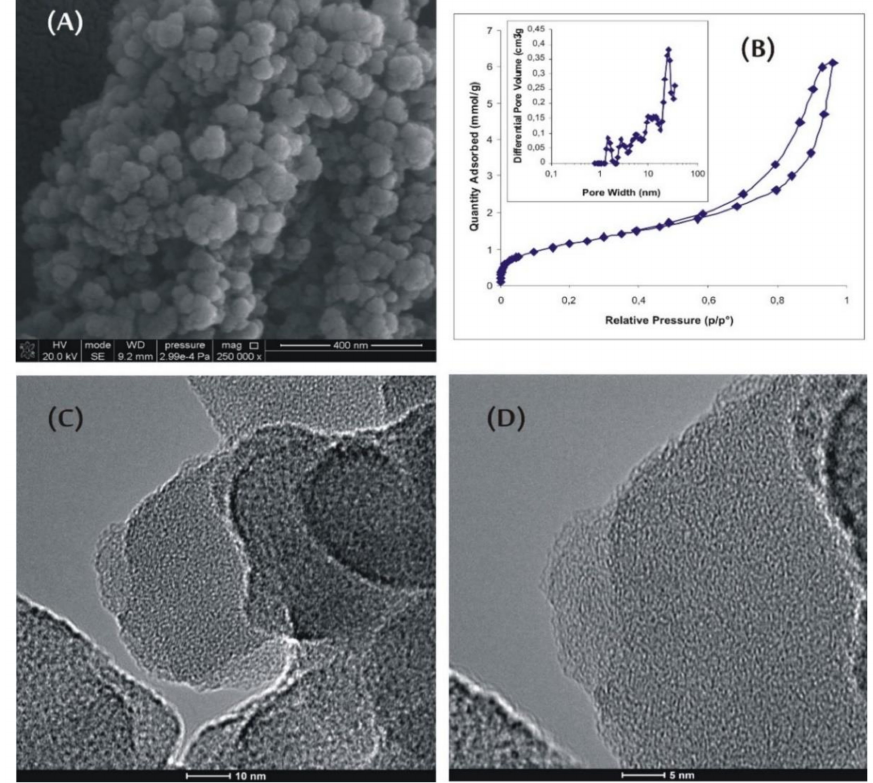
Figure 1. Morphology of amorphous-carbon-nanomaterial (ACNM) sample: ( A ) SEM image, ( B ) low-temperature (77 K) N 2 adsorption isotherm, and ( C , D ) HRTEM images.